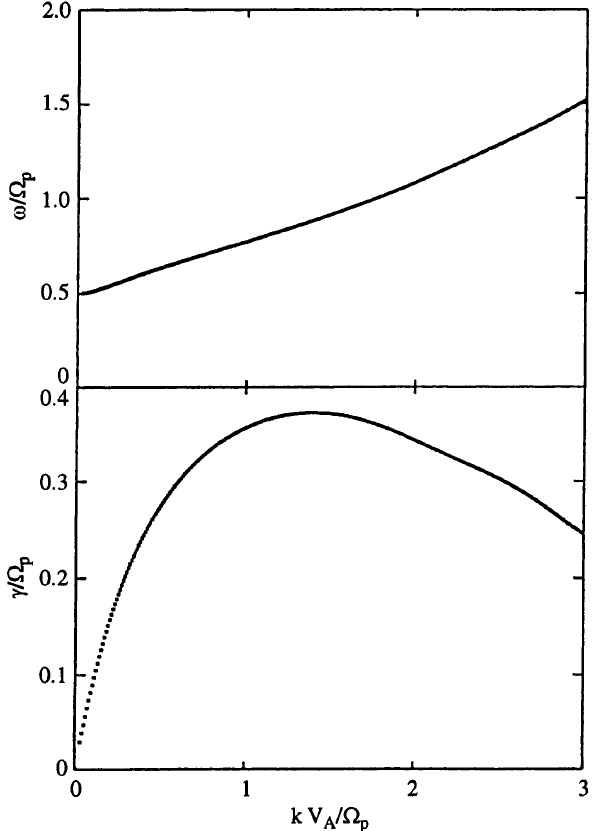
Fig. 7. Perpendicular propagating unstable extra ordinary mode forced by a rotating nongyrotropy (Motschmann and